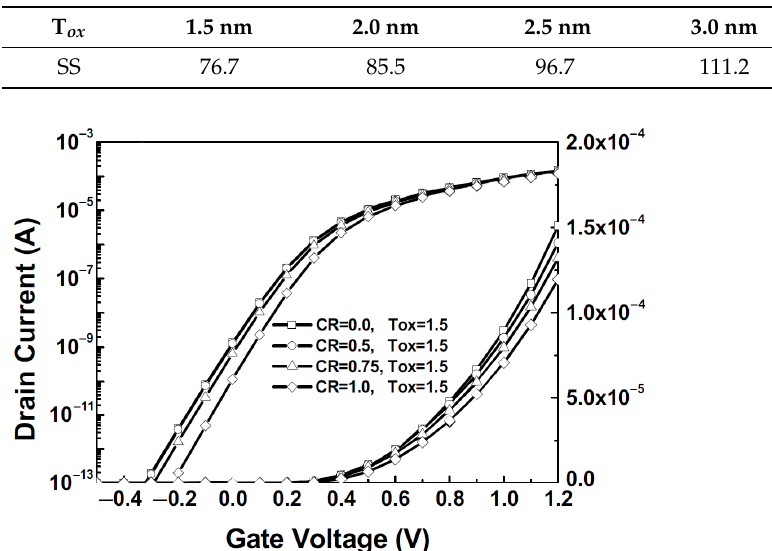
Table 3. Subthreshold swings as a function of Tox (SS, Subthreshold swing mV/dec).